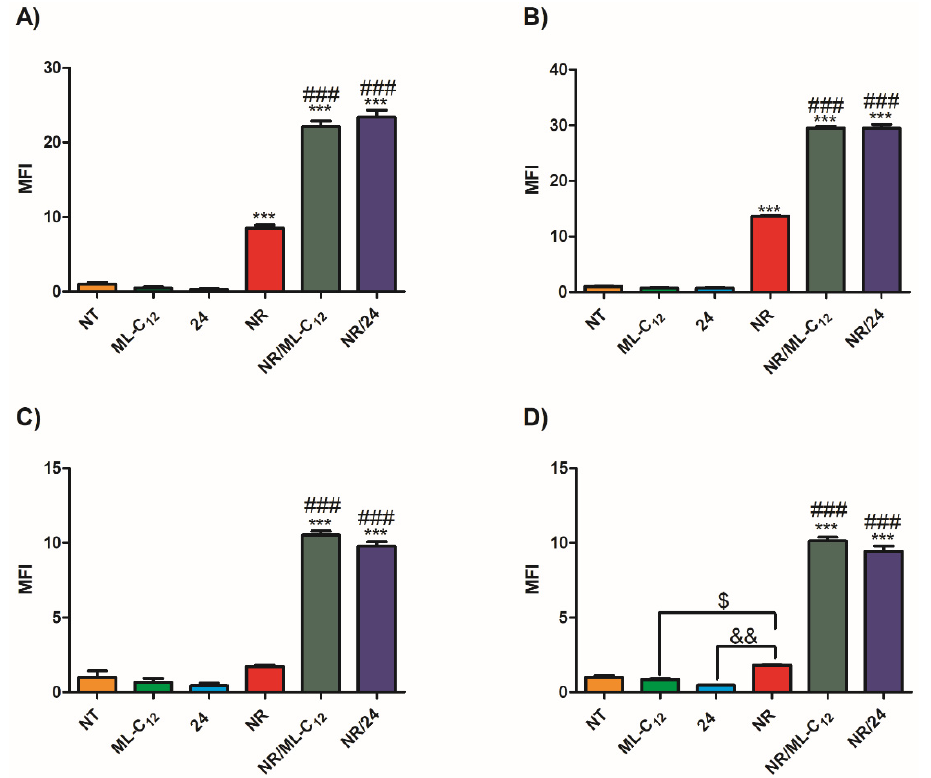
Figure 5. Nile red (NR) uptake by ( A ) JAWSII, ( B ) J774A.1, ( C ) HCT 116, ( D ) A2780 cells with ML-C 12 or 24. Cells were seeded at 3 × 10 5 cells in 300 µ L in a 96 multi-well plate and were left untreated (NT) or were treated with 10 µ g/mL of empty ML-C 12 or 24 , 1 µ g/mL of Nile Red (NR), or 1 µ g/mL of Nile Red encapsulated in 10 µ g/mL of liposome (ML-C 12 or 24 ). Cells were collected after 1 h at 37 ◦ C, washed once with 300 µ L of PBS, and suspended in 300 µ L of PBS. Mean fluorescence intensity (MFI) of singlets was measured by flow cytometry (10 4 events). Data is normalized to the NT control (MFI = 1). Statistical differences were measured using a one-way ANOVA with a Tukey’s HSD where *** p < 0.001 as compared to NT, ML-C 12 and 24 , $ p < 0.05 as compared to ML-C 12 , && p < 0.01 as compared to 24, and ### p < 0.001 as compared to NR alone. Data are shown as the average ± SEM of a triplicate from one